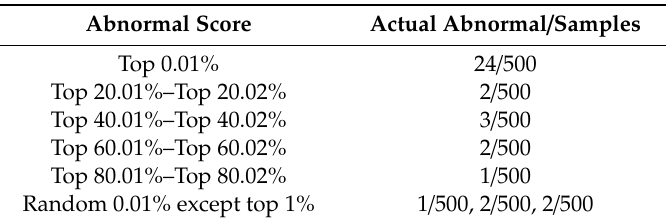
Table 6. Abnormal Score vs. Actual Abnormal